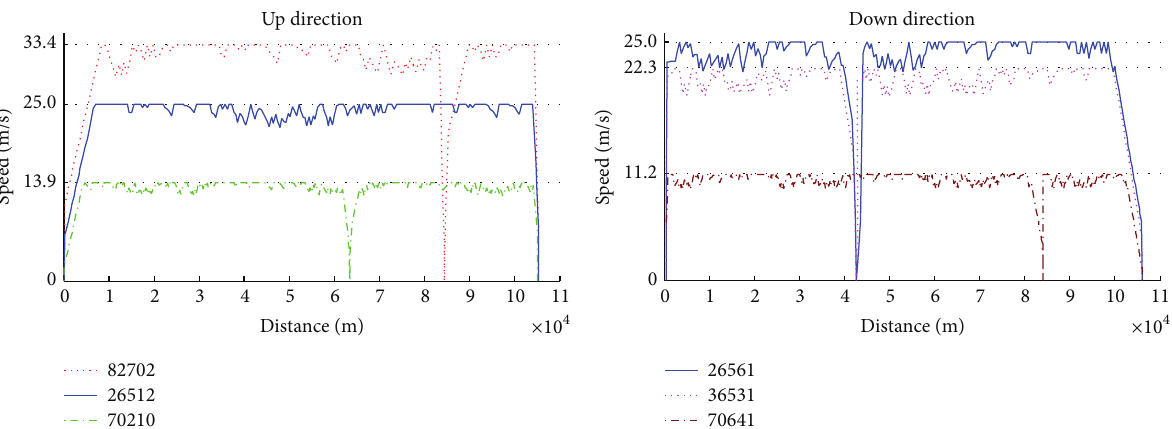
Figure 15: Train speed-distance curve (NCBS number: